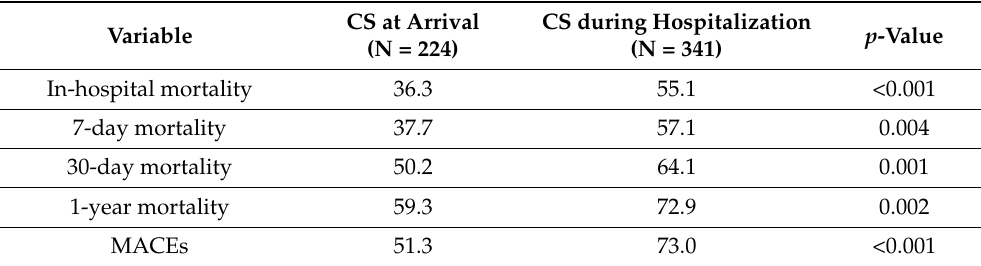
Table 4. Patient outcomes of patients with ACS and CS at arrival versus patients who developed CS during